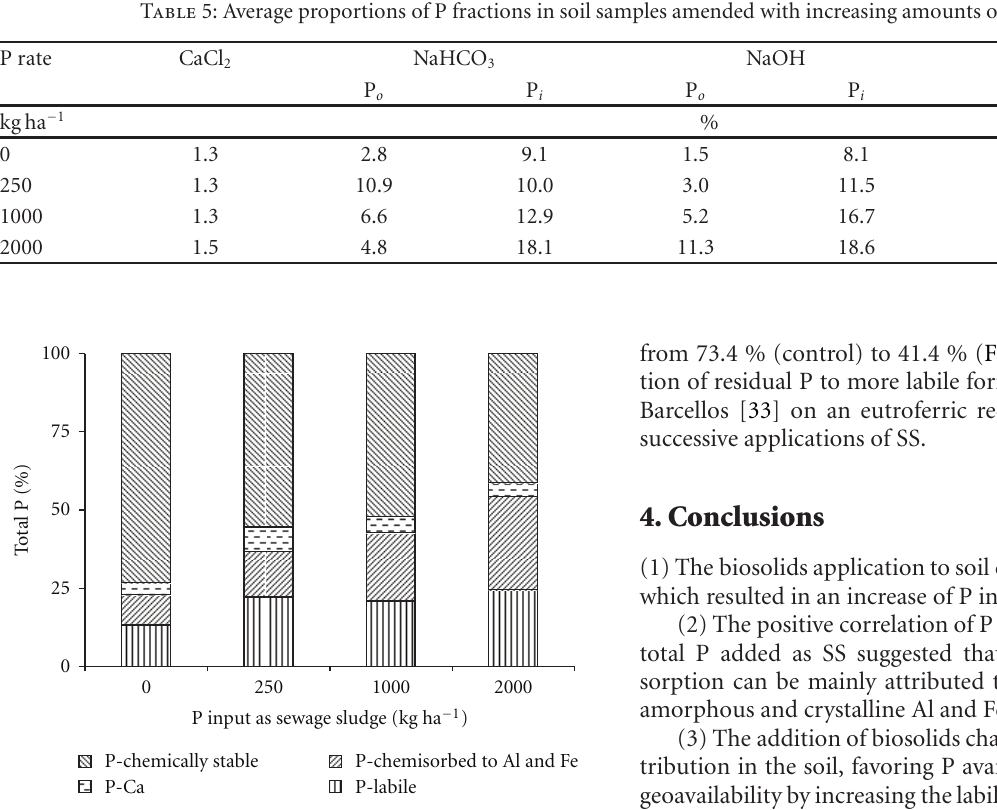
Figure 2: Percent distribution of P fractions in soil samples amend- ed with increasing amounts of biosolids from Barueri